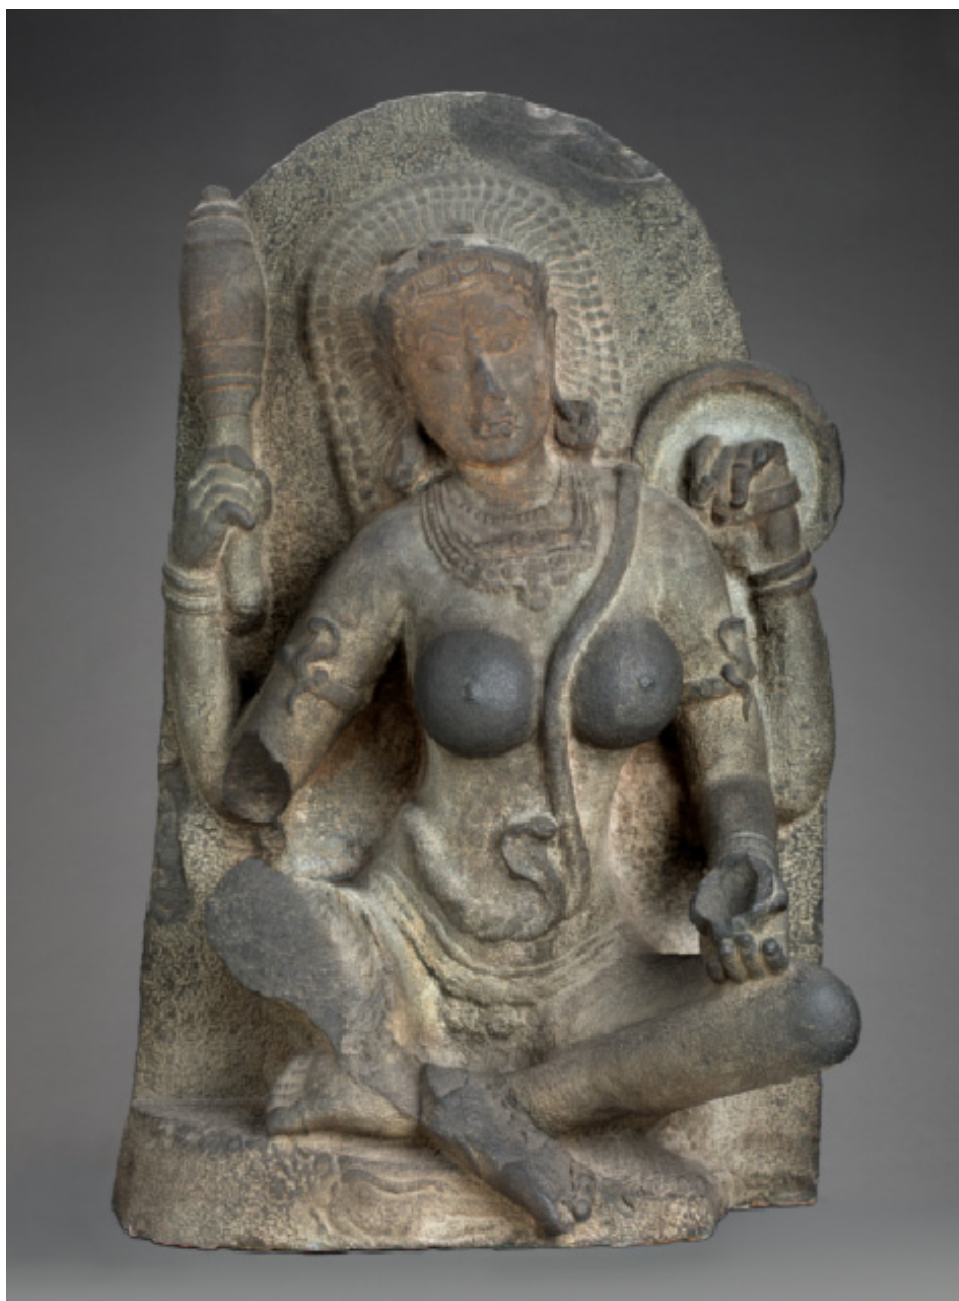
Figure 1. Yogini, Tamil Nadu, late 9th–mid-10th century. 46 × 29 × 20 in. (116.8 × 73.7 × 50.8 cm). Detroit Institute of Arts, Founders Society Purchase, L. A. Young Fund, 57.88.